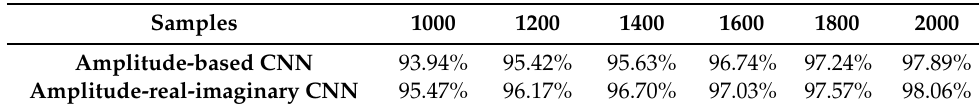
Figure 9. Experimental results based on different networks under SOC. Table 4. Classification accuracy based on different networks under SOC.